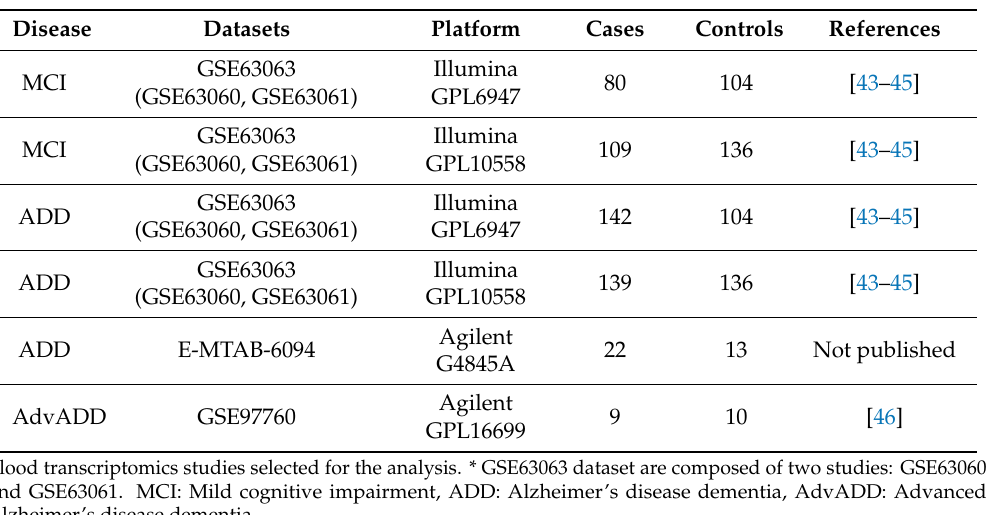
Table 1. Gene expression datasets used in this study.